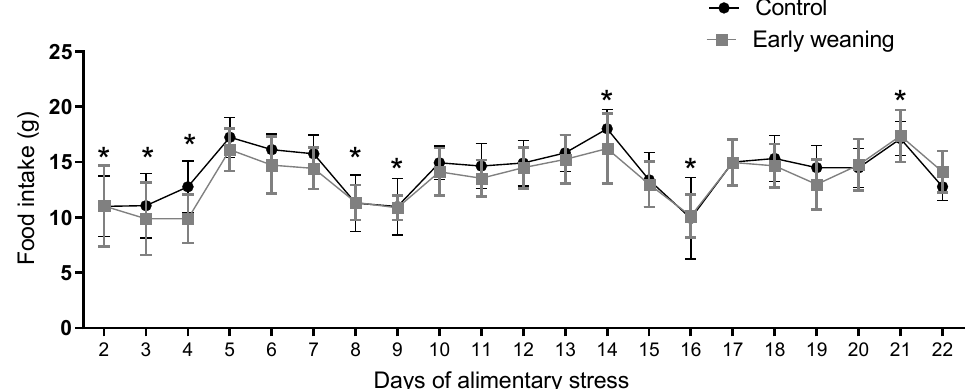
Figure 5. Effect of Early Weaning associated with chronic stress over standard diet intake. Data were obtained every 24 hrs between days 2 and 22 of alimentary stress. Two-way ANOVA. Bonferroni’s post-hoc test n = 8. Data expressed as mean ± SD. * Shows the points where both groups showed statistically lower values when compared to the highest levels.